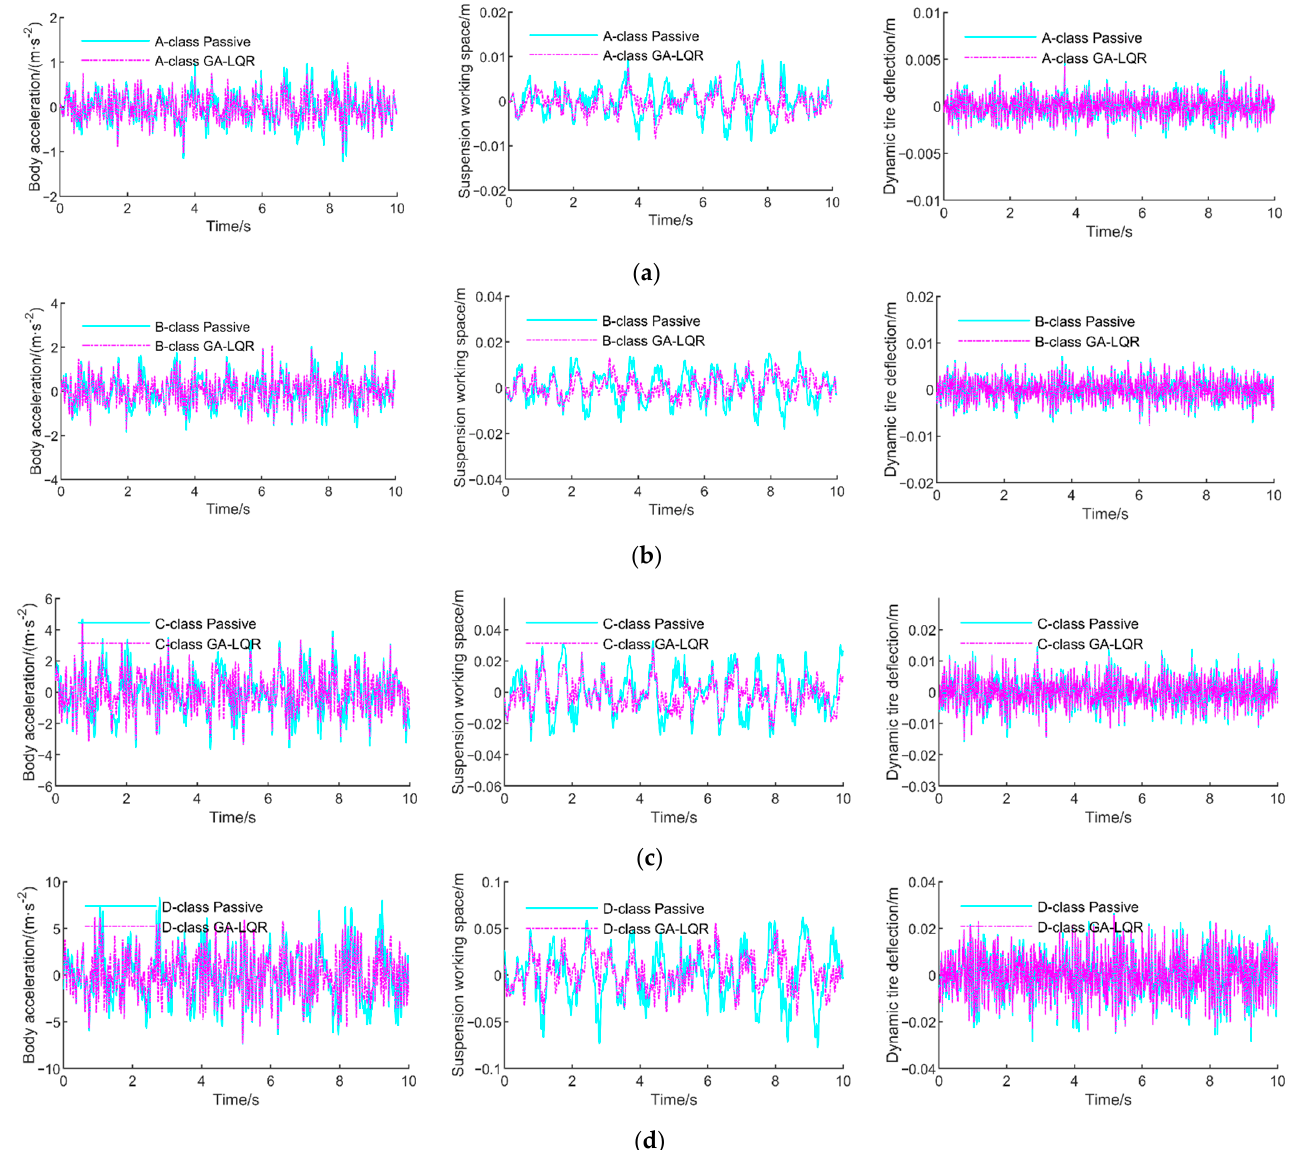
Figure 6. Comparison curves of time domain response for two suspensions (passive suspension and active suspension based on GA-LQR) at four road classes: ( a ) A-class road; ( b ) B-class road; ( c ) C-class road; ( d ) D-class road.